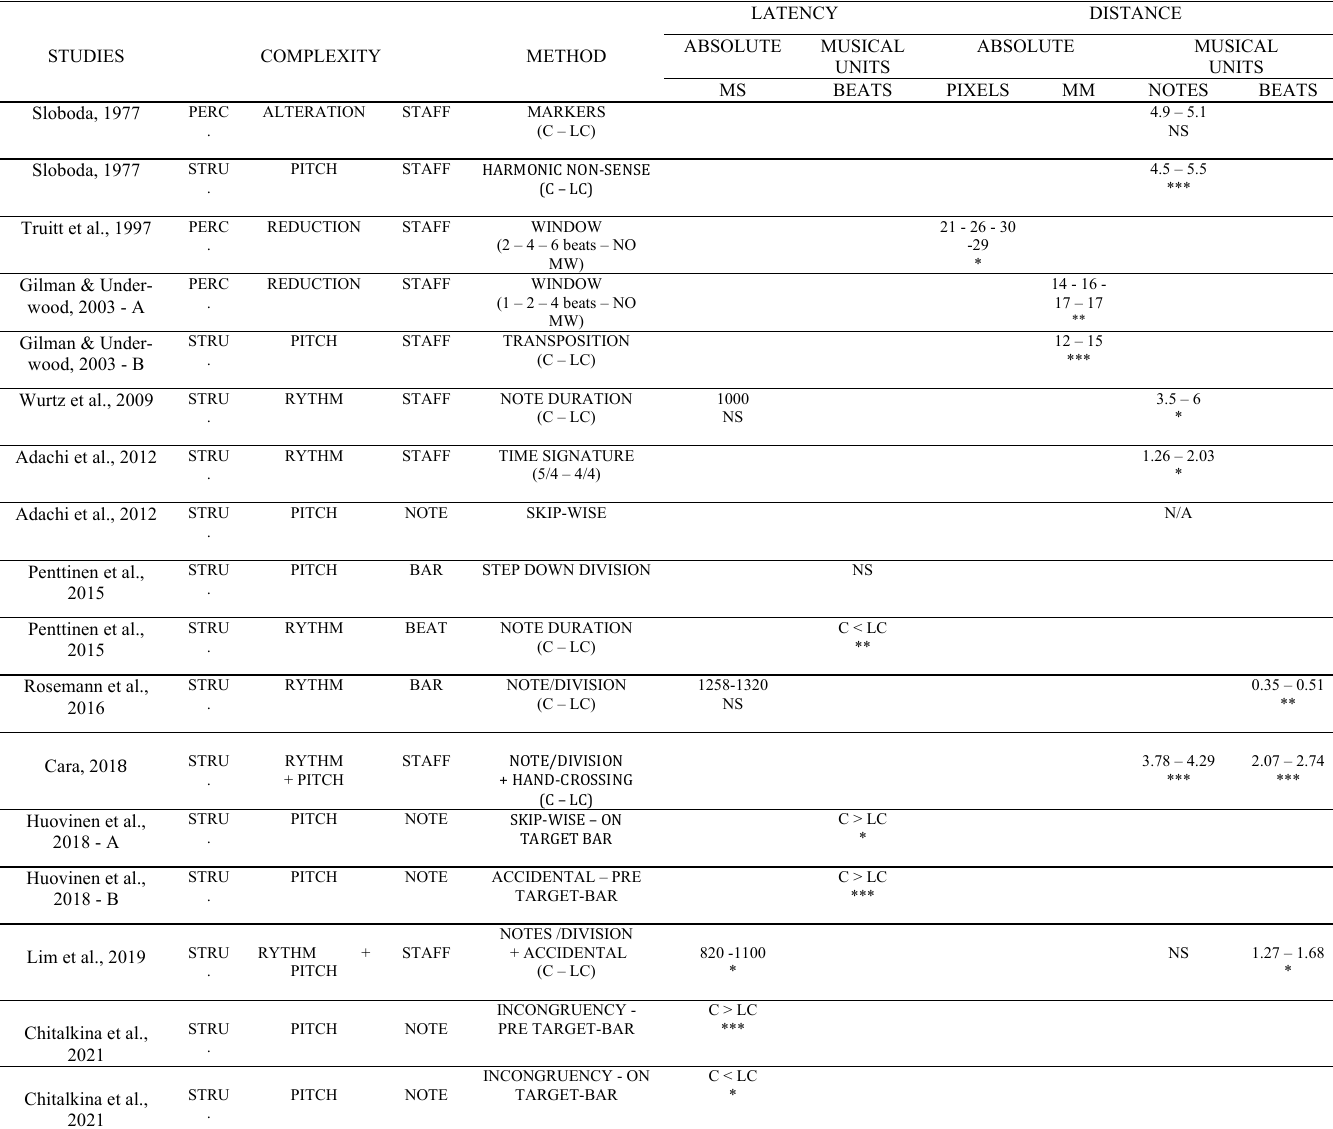
Table 4. Eye-Hand Span as a function of